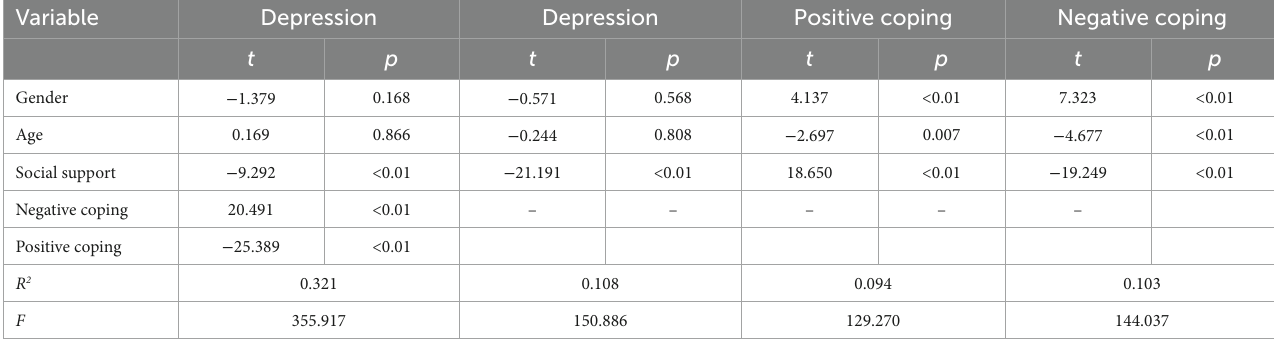
TABLE 3 Mediated variable testing: coping style. Variable